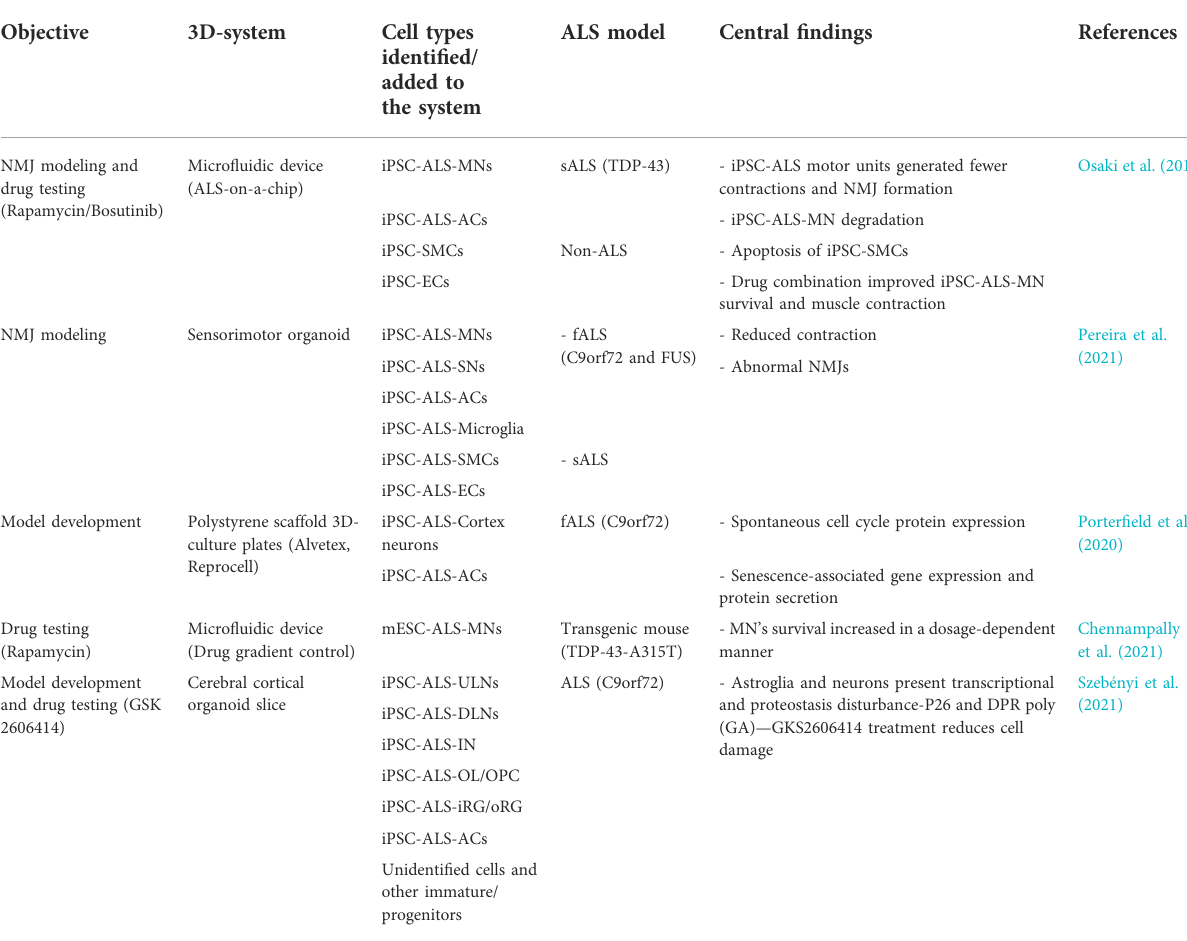
TABLE 1 3D-culture models implemented in the study of